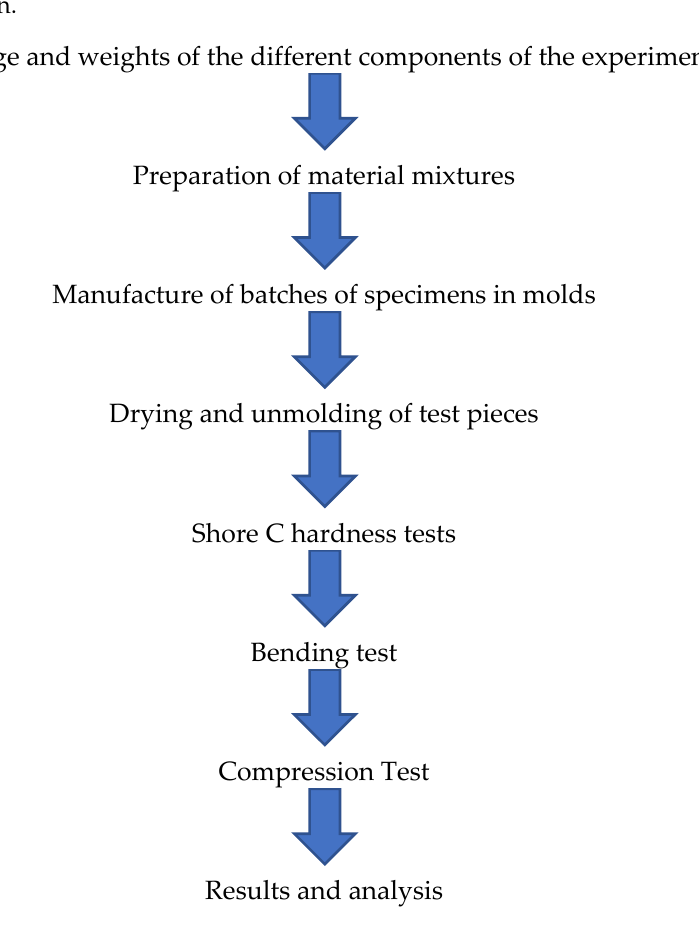
Table 6. Quantity of dosages of the different materials used in the mixture. Ref. Contrast Ref. Test Additive (%)